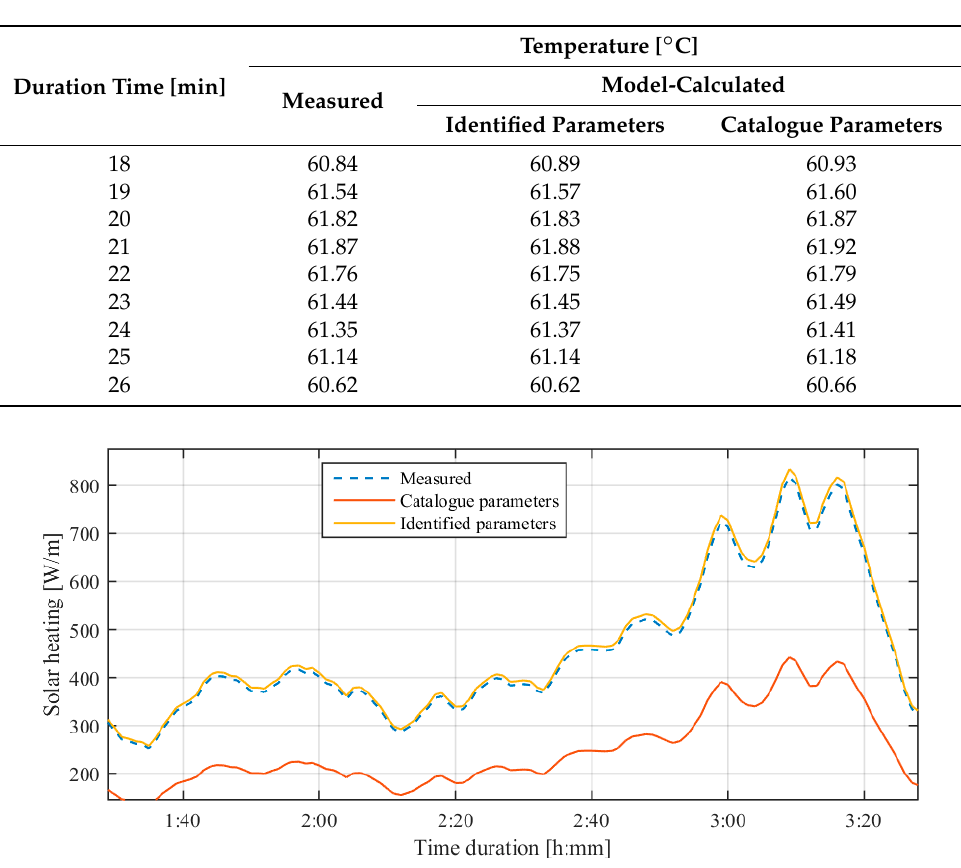
Table 10. Measured and model-calculated temperature using catalogue and identified parameters from the Figure 6.